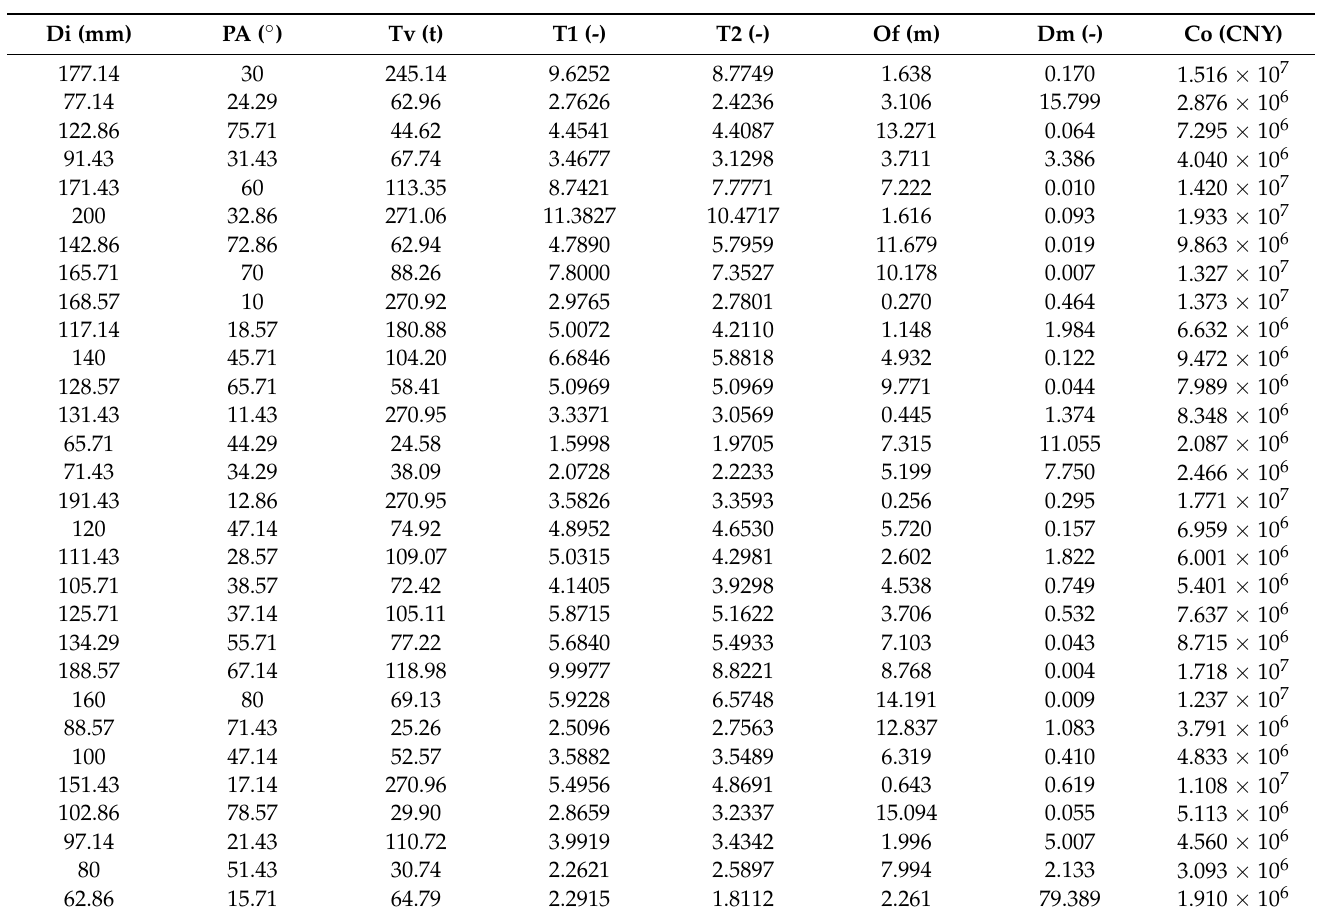
Table A2. List of the sample point information by